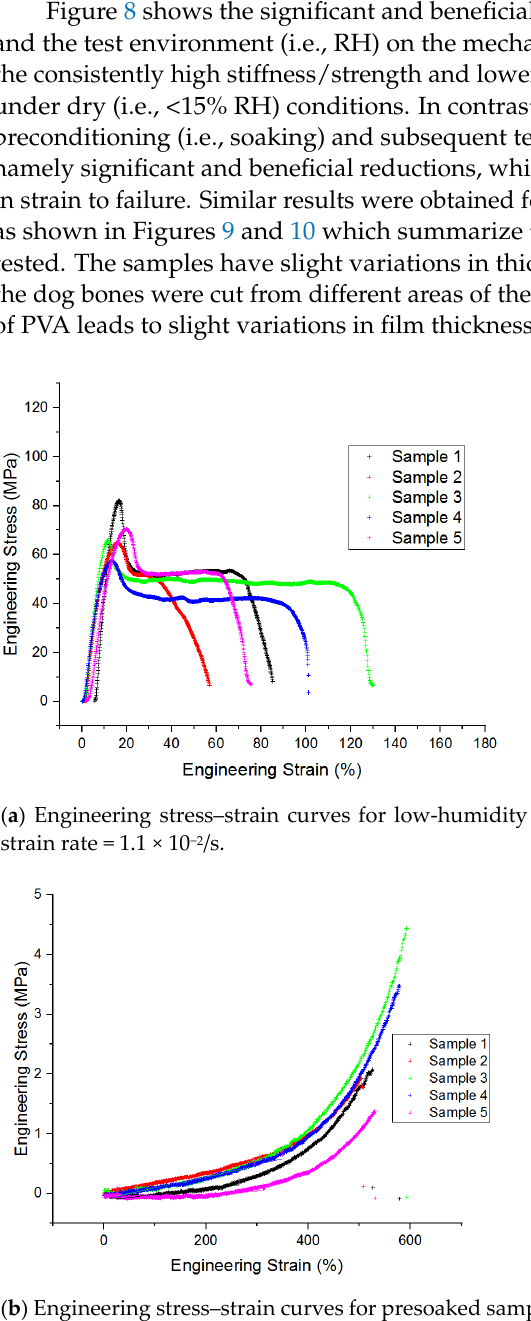
Figure 8. Change in stiffness/modulus and characteristic stress-strain curve upon wetting fully hydrolyzed PVA films. Semi-crystalline behavior is observed in the dry samples ( a ) tested at low humidity (<15% RH) while a J-curve reminiscent of biological tissue or a prestressed elastomer is observed in the presoaked samples ( b ) tested at high humidity (50% RH).